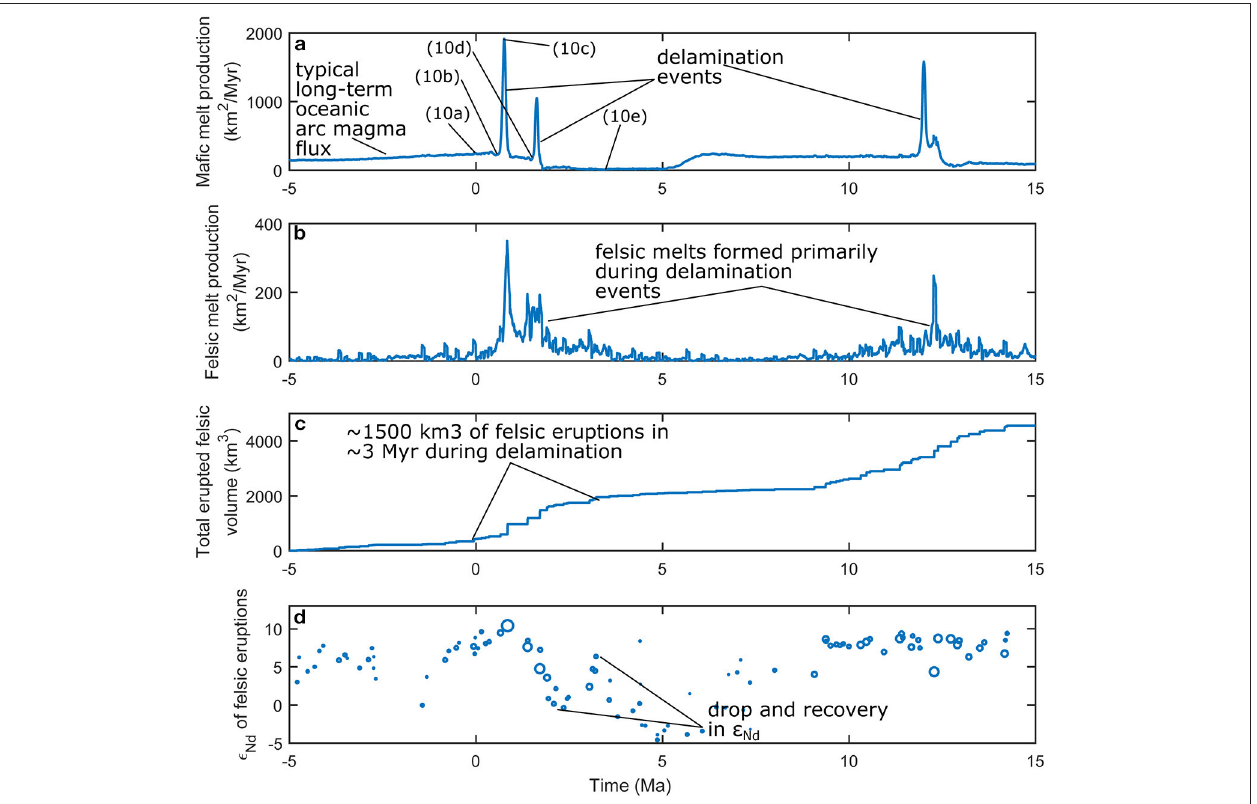
FIGURE 11 | Melt production and volcanism during the delamination event depicted in Figure 10 . (a) The surge in mantle melting lasts < 2 Myr, and is punctuated by sharp spikes associated with the actual dripping events. (b) The increase in mantle melting is associated with a coeval spike in the production of felsic melts in the crust (including intrusions), and (c) in the rate of eruption of rhyolites on the surface (to calculate 3D volumes here we assume a model thickness of 20km). (d) Finally, we note that the surge in rhyolitic volcanism is associated with a noticeable drop in ε Hf used in our models (which linearly correlates with ε Nd ) values as a result of a surge of crustal melting. This demonstrates that an increase in mantle melting alone can trigger a drop in ε Nd values, making the underthrusting of fertile crustal material not necessary for all such arc flareup events ( Ducea and Barton, 2007; DeCelles et al.,